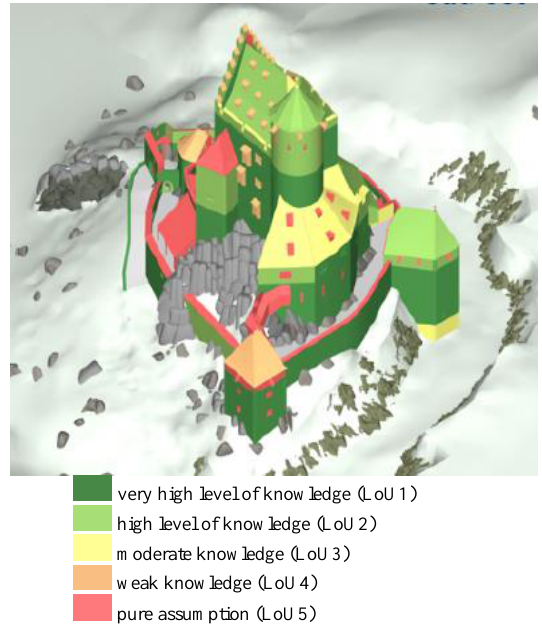
Figure 10: Uncertainty visualization based on five levels of uncertainty (LoUs), for the castle of Kagenfels, Alsace (south- east point of